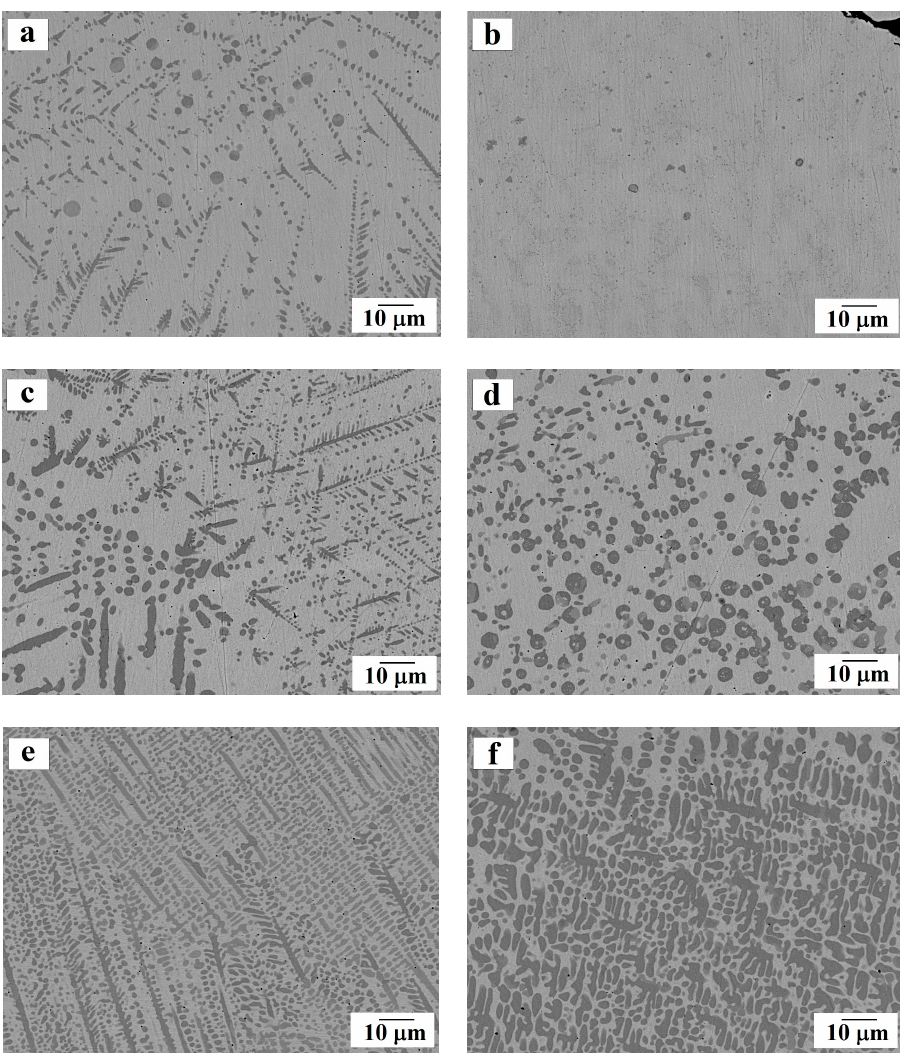
Figure 5. The microstructure of the central part of the obtained coating (according to SEM data) for samples: ( a ) and ( b ) No. 2; ( c ) and ( d ) No. 3; ( e ) No. 4; ( f ) No. 5.